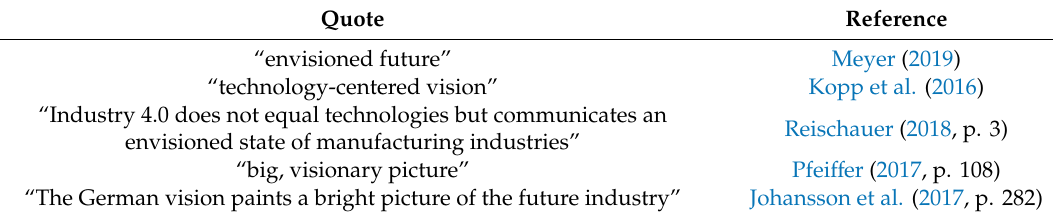
Table 1. Visionary aspects of the Industry 4.0 (I4.0) concept (Source: Author’s own